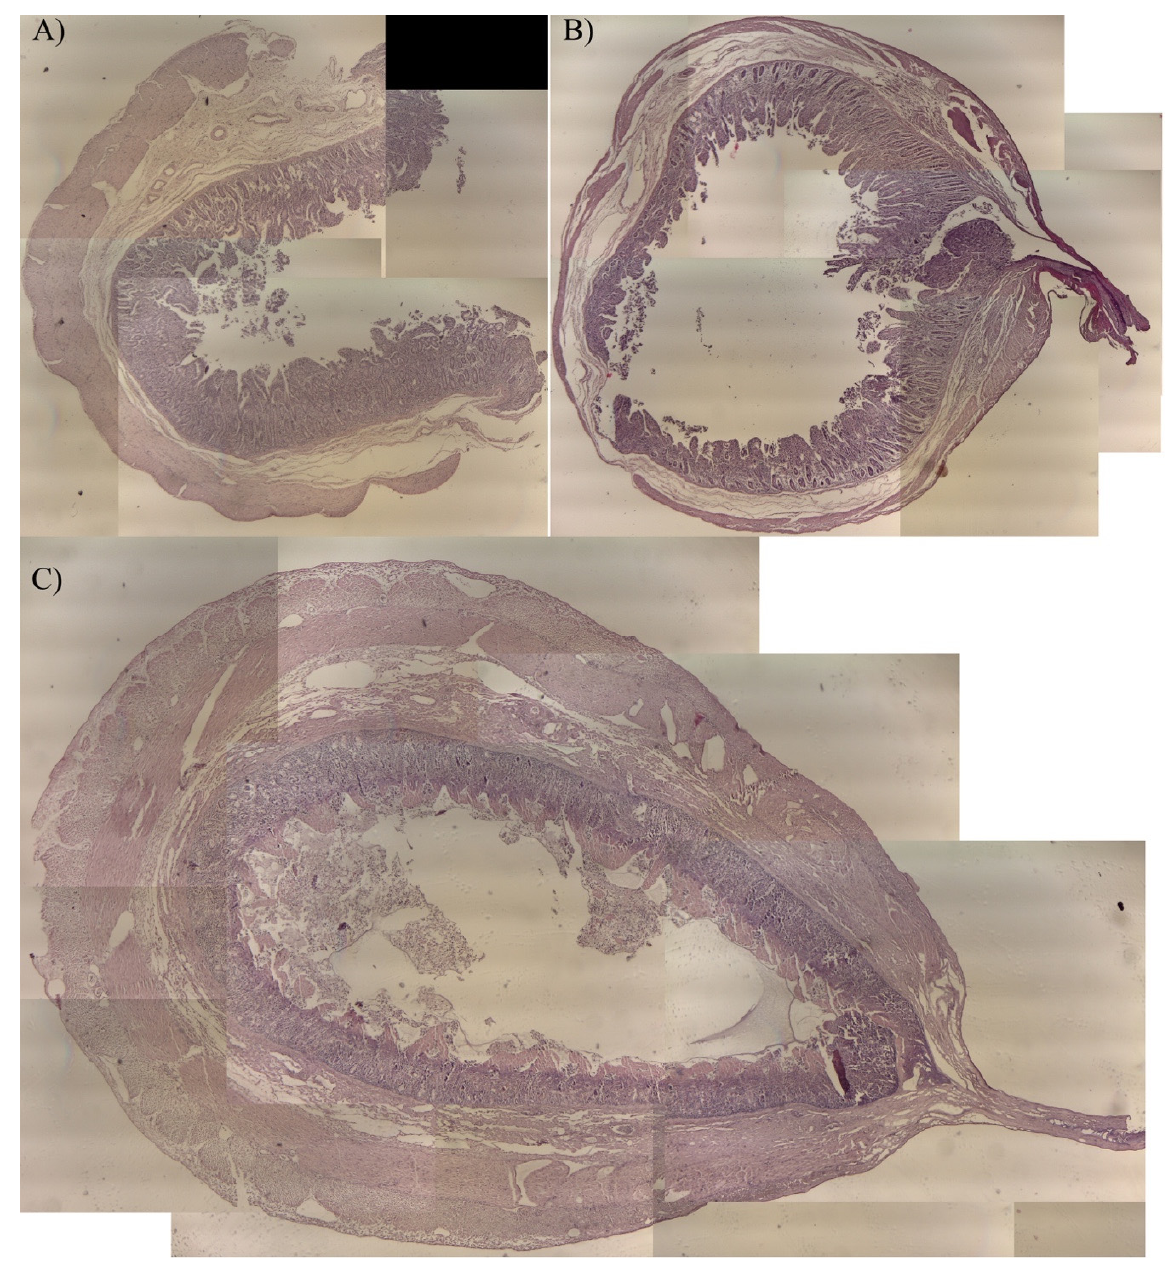
Figure 12. Representative histological images obtained merging different fields of view at 4× magnification (E.E.). Cross sectional slides from biopsies obtained in study arm 2. ( A ): Group Suture (biopsies obtained with cold blade); ( B ): RFVS-1; C: RFVS-3.